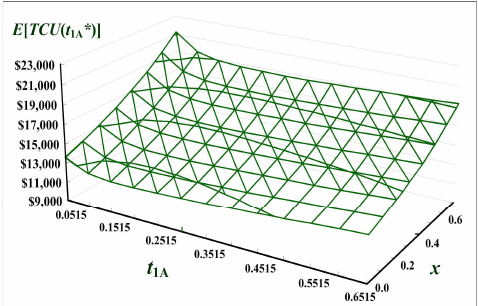
Fig. 16. The joint effect of differences in uptime t 1A and random scrap rate x on E [ TCU ( t 1A *)]